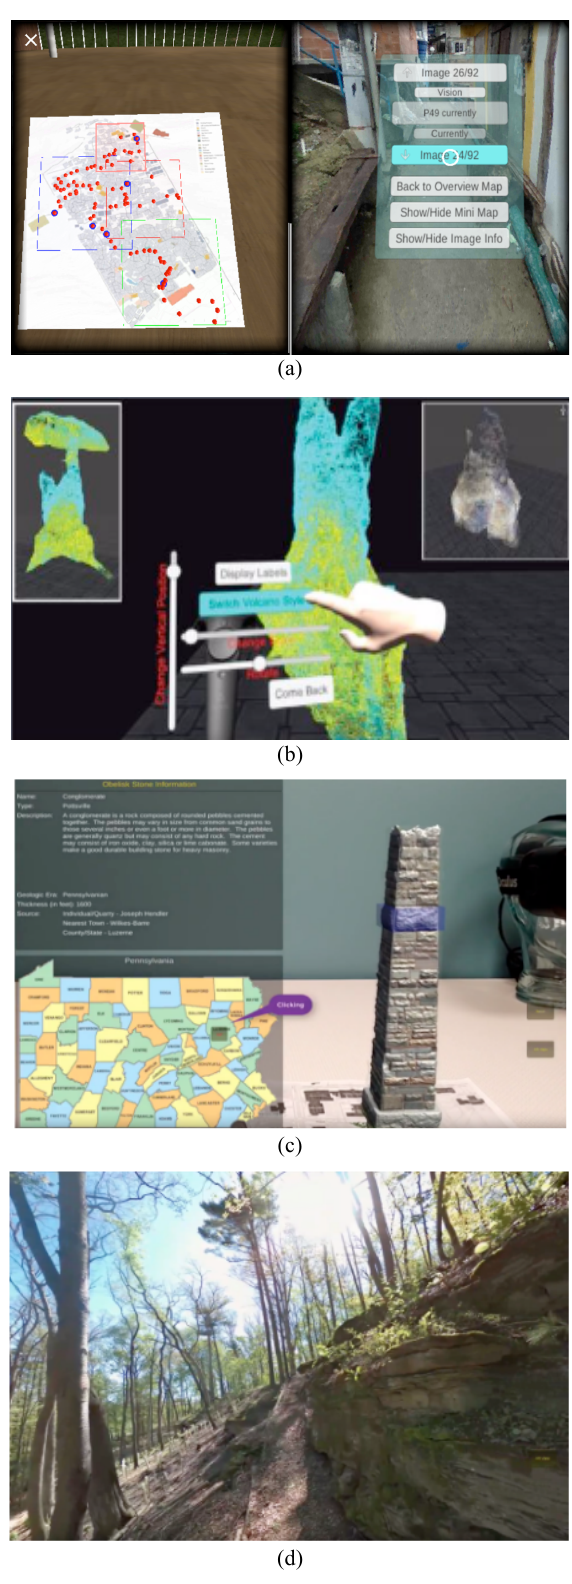
Figure 4. (a) Mobile VR experience of an informal settlement from a study with (landscape) architecture students. (b) VR experience of the Icelandic volcano Thrihnukar for geoscientist including different measuring tools. (c) Marker-based AR prototype displaying historic information for the Penn State Obelisk. (d) 360° view in the AR prototype showing the natural environment that a stone in the Obelisk originated